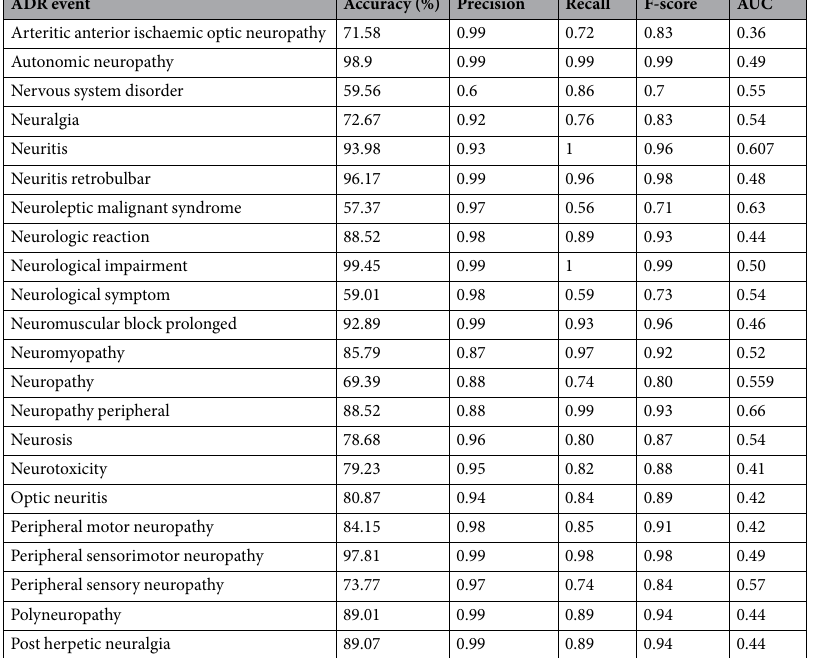
Table 3. Provides the performances of the models generated using the biological features.